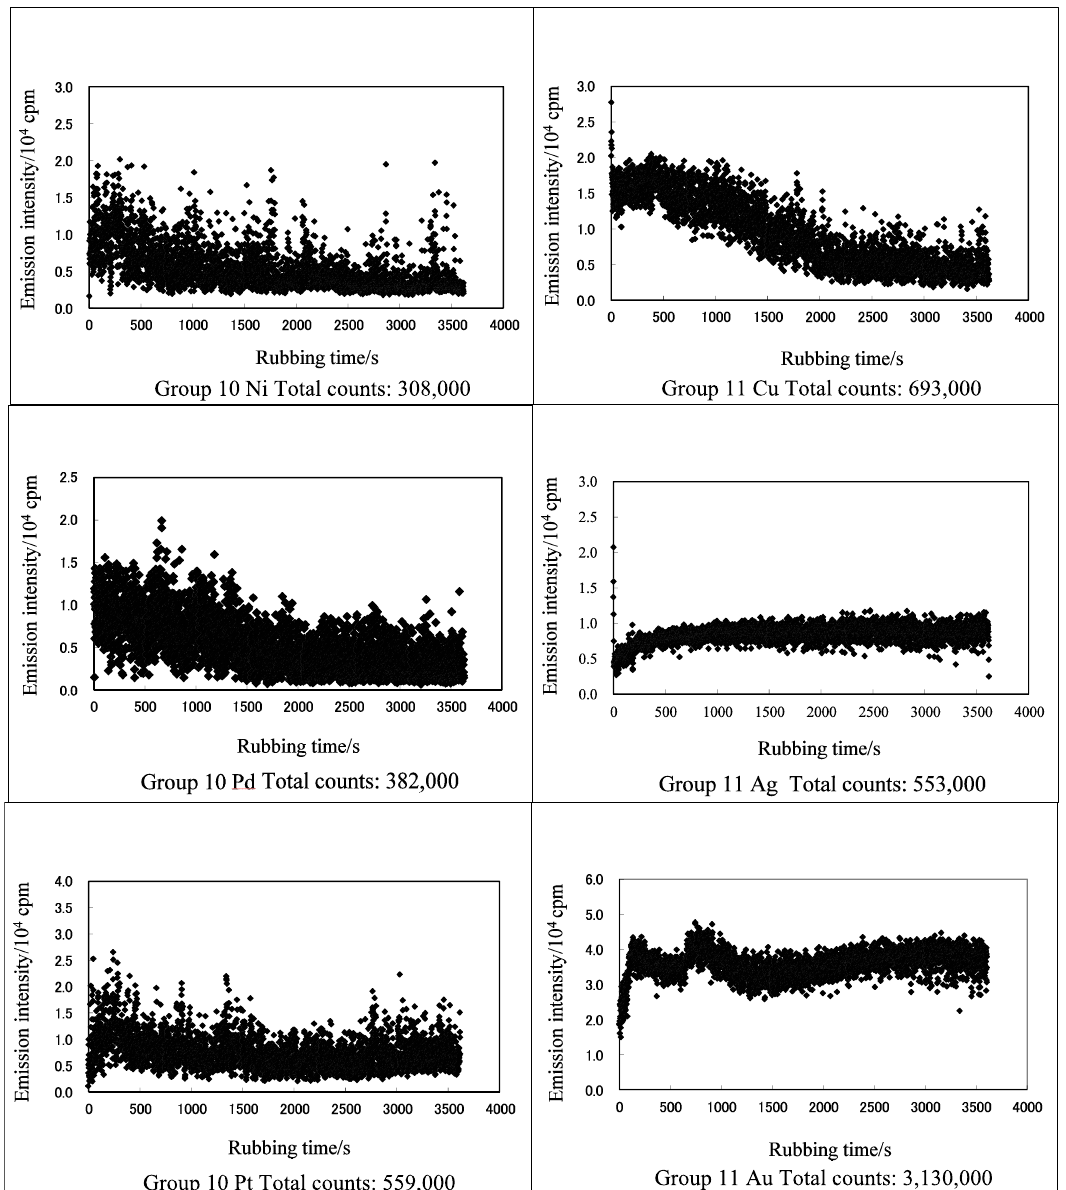
Figure 3. The change in intensity (cpm: counts/min) of TriboEE with rubbing time for groups 10 (Ni, Pd, and Pt) and 11 (Cu, Ag, and Au), giving the median value of TriboEE intensity.